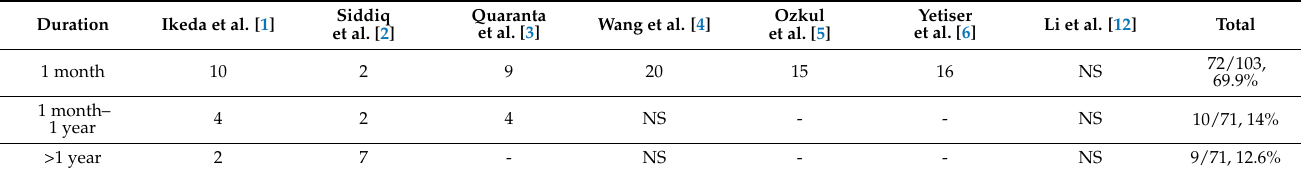
Table 5. Number of patients in different studies according to duration time of facial palsy until surgery (removal of cholesteatoma and facial decompression), NS: not